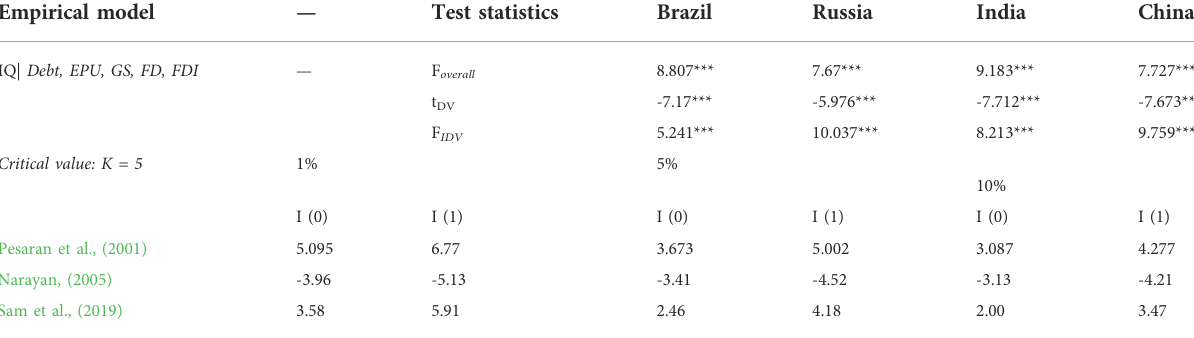
TABLE 5 AARDL cointegration test. Empirical